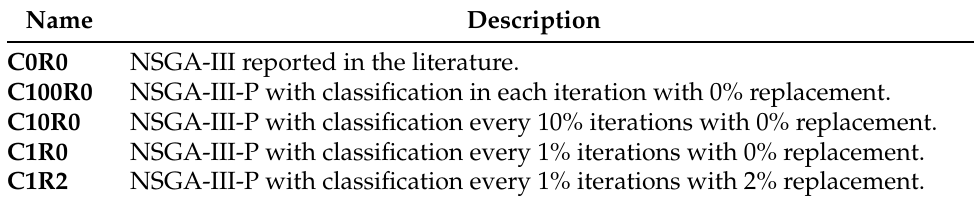
Table 3. Experimental configurations carried